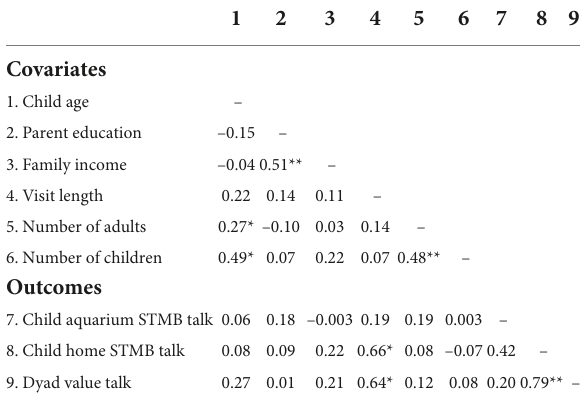
the stepwise method, to explore initial models, predicting